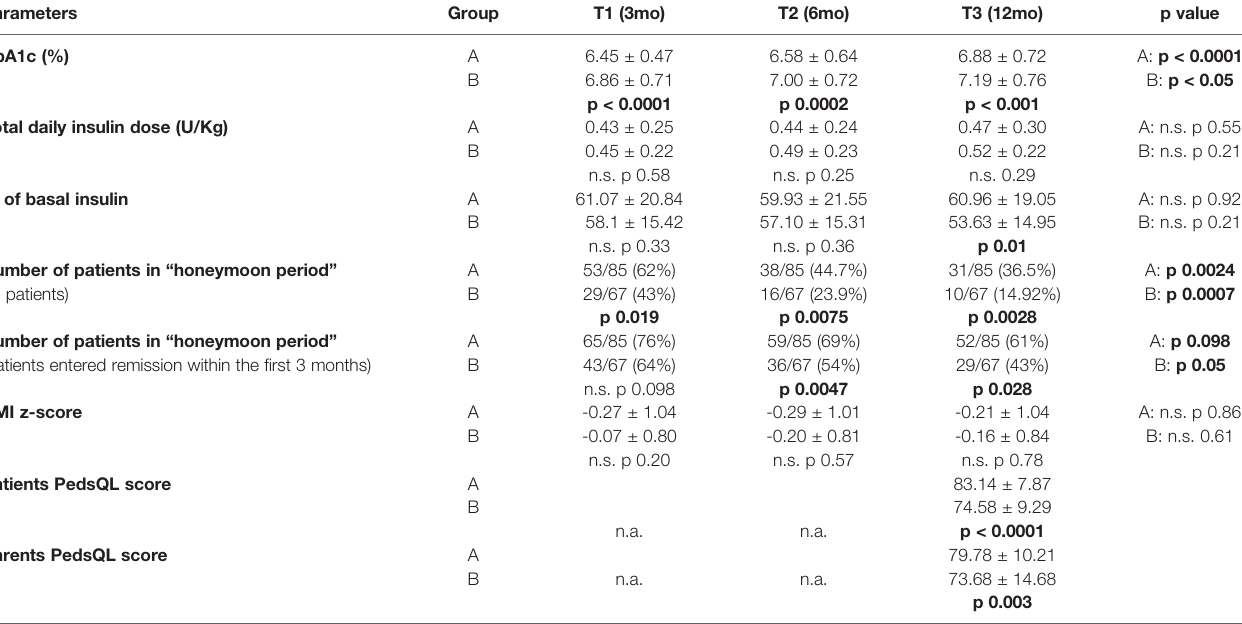
TABLE 2 | follow up data in Group A (n = 85) and B (n = 67).